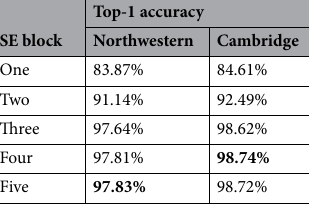
Table 2. Accuracy comparison of network structure. Significant values are in bold.